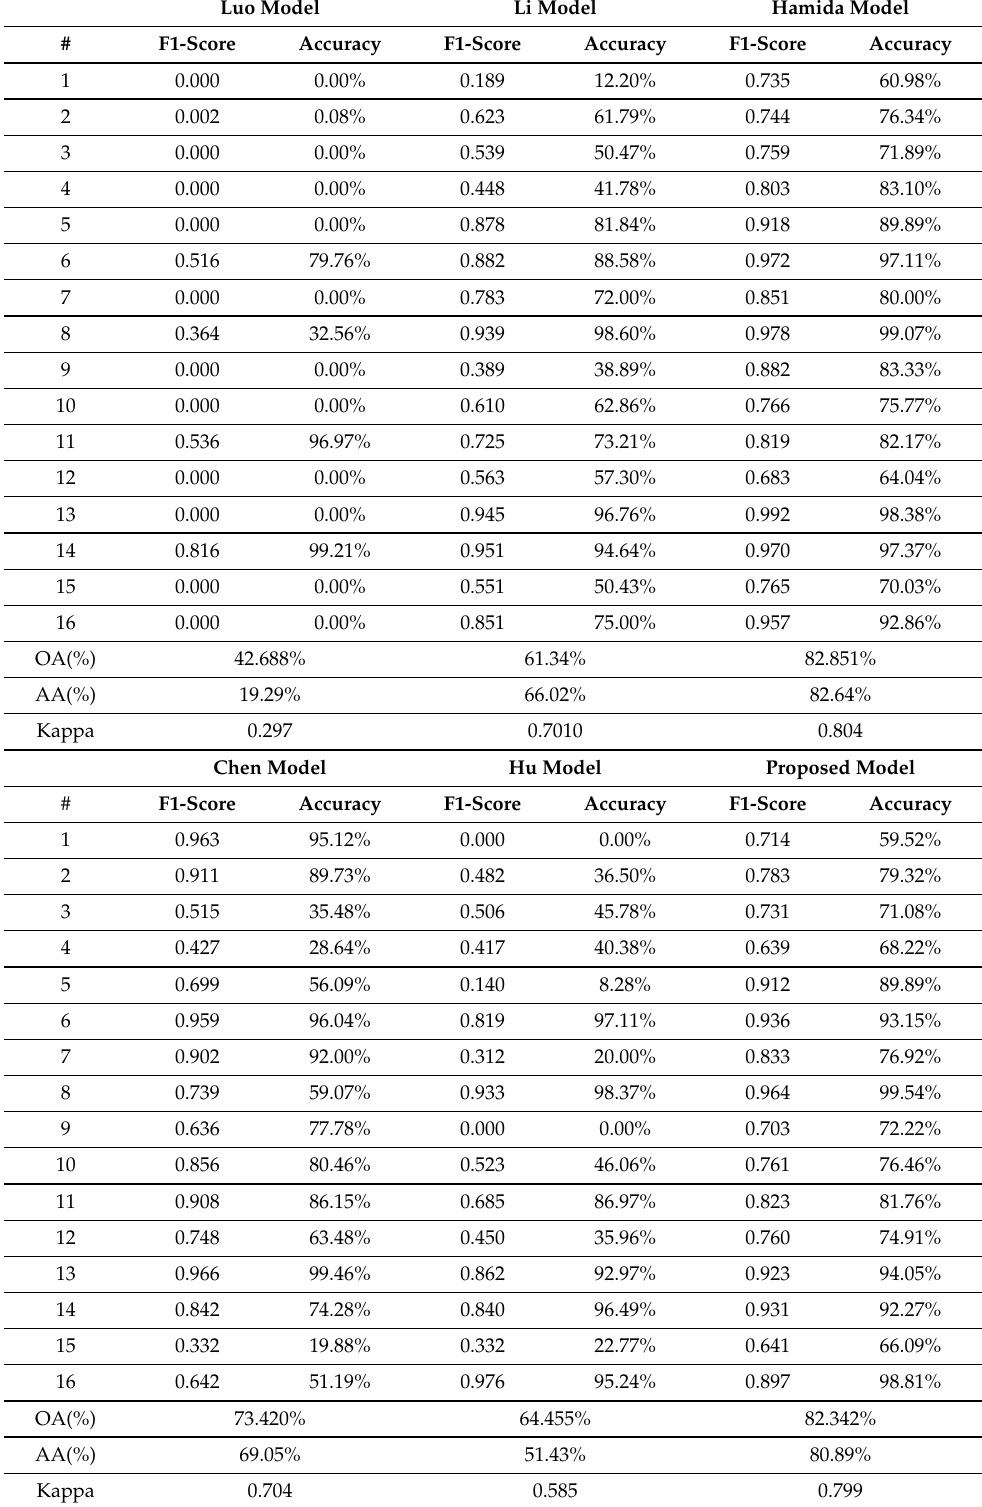
Table 6. Classification results of the Indian Pines dataset to which random spatial information is not